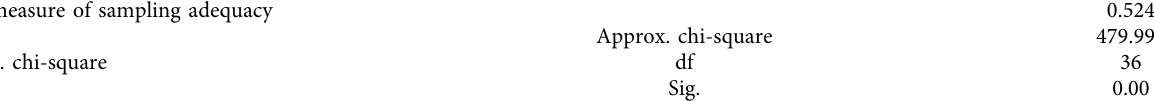
Table 5: The KMO and Bartlett’s test.